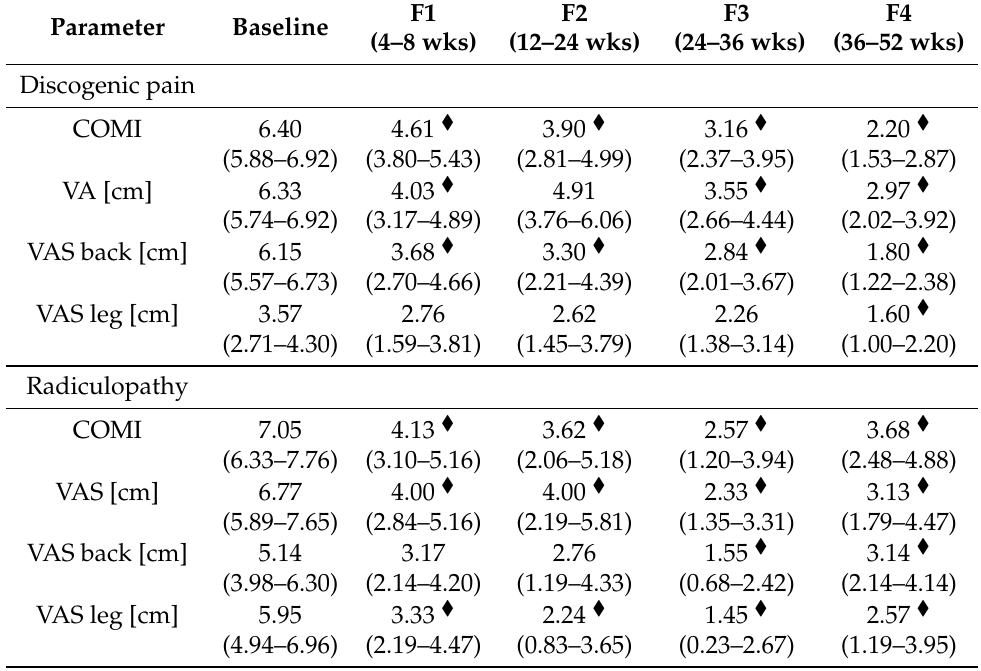
Table 2. Questionnaire results at baseline and subsequent follow-ups (F1–F4). Data are presented as mean (95%CI). A black lozenge indicates the follow–up values that were statistically different than those of